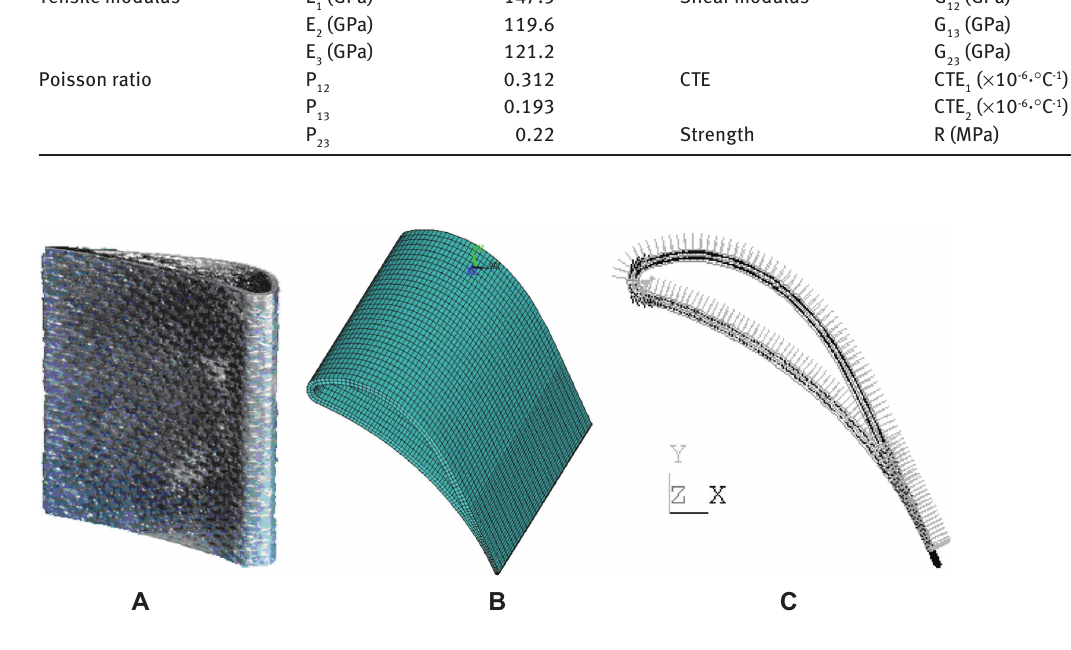
Figure 2 Vane structure of C/SiC woven